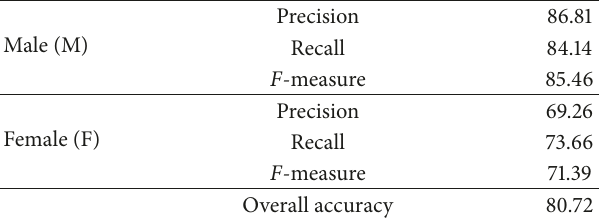
Table 5: Performance results for combined gender-and-handedness classification on IAM database.